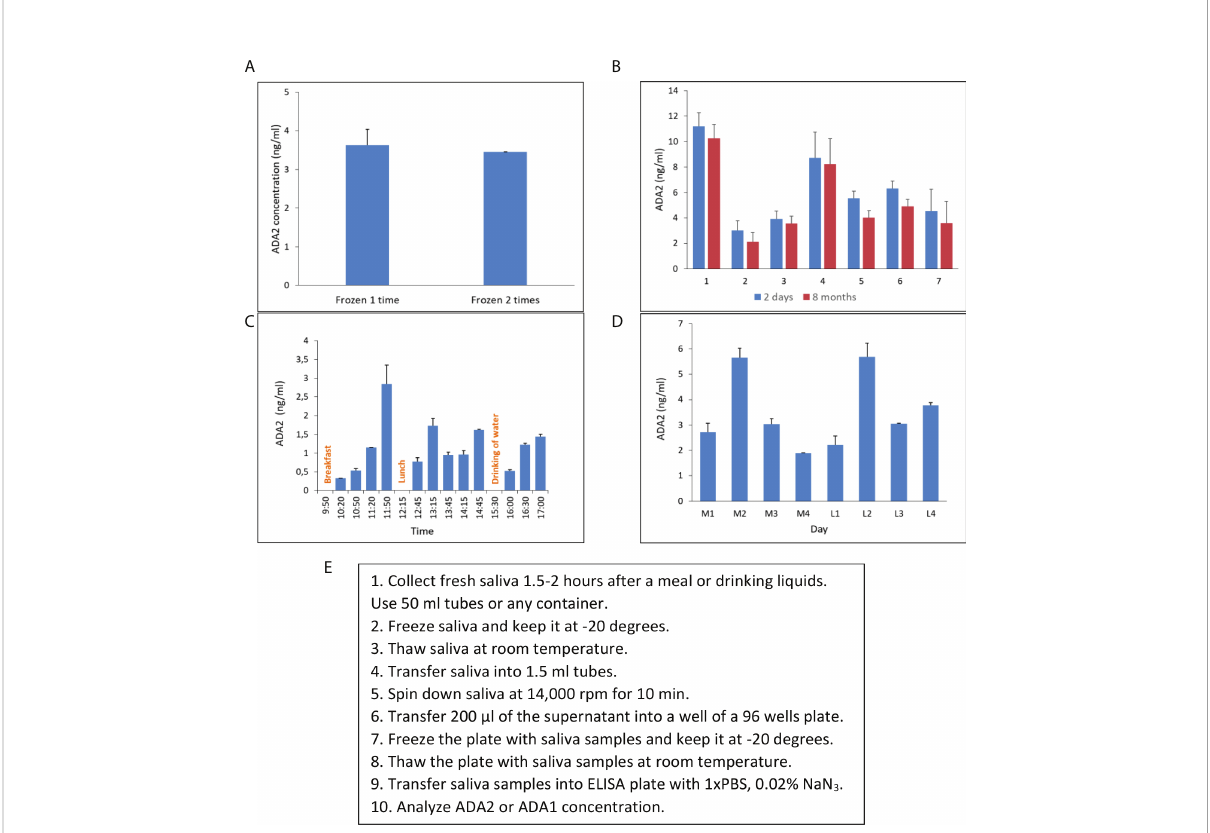
FIGURE 4 Saliva collecting and storage. (A) ADA2 concentration in a saliva sample frozen either one or two times. (B) The concentration of ADA2 in seven saliva samples that were stored for two days or eight months at -20°C. (C) Changes in ADA2 concentration in saliva during the day. Saliva samples were collected from a single donor at different times after breakfast, lunch, or drinking of liquids. (D) ADA2 concentration in saliva during four consequent days. The samples were taken in the morning on an empty stomach (M1-M4) and one hour after lunch (L1-L4). The data is the mean value of two replicates. (E) Saliva collecting and storage protocol. The ADA2 concentrations were detected according to the method described in Figure